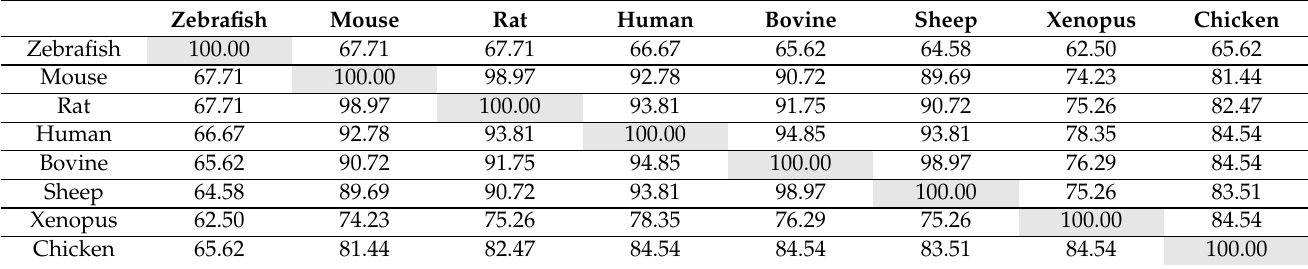
Table 1. Amino acid sequence homology of NPY among several